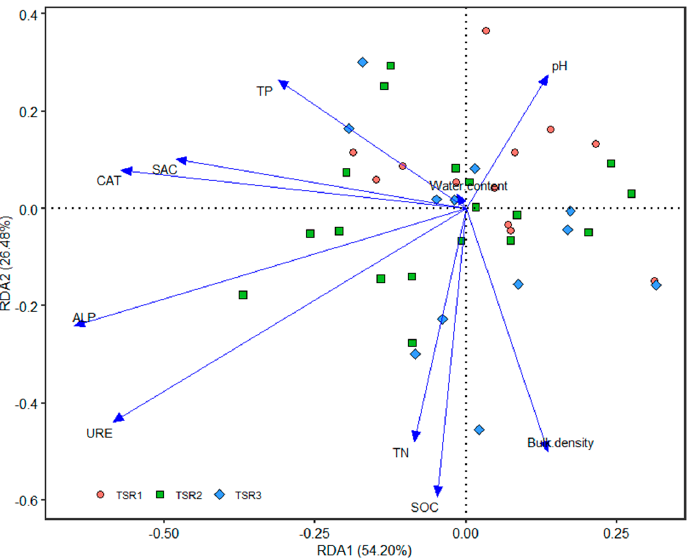
Figure 7. Redundancy analysis (RDA) illustrates the relationship between the phylum composition of soil fungal communities and environmental variables in tree clusters of varying tree species richness with one, two, and three tree species combinations in subtropical evergreen broad-leaved forest. SOC: Soil organic carbon, URE: urease, ALP: Acid phosphatase, SAC: Invertase, CAT: Catalase. TSR1: tree species richness 1, TSR2: tree species richness 2, TSR3: tree species richness